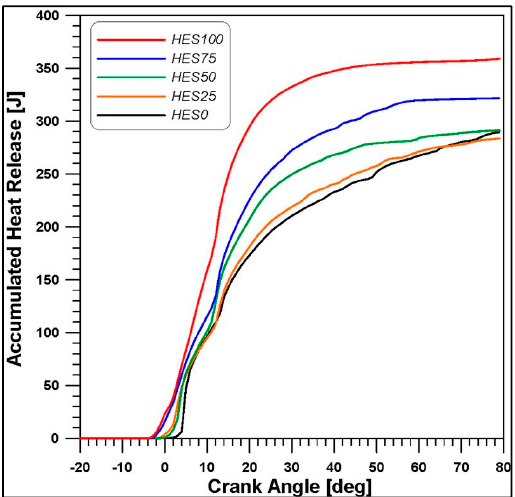
Figure 18. Accumulated chemical heat release.